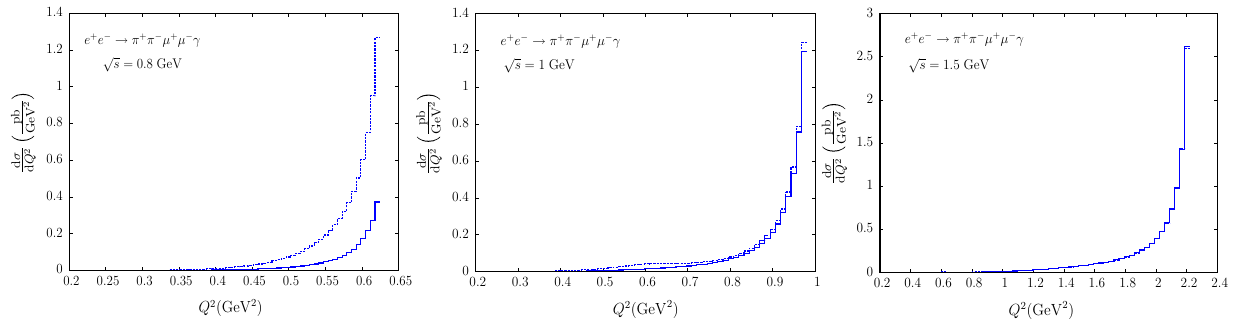
Fig. 16 The differential cross sections of (10) as functions of invariant mass of the π + π − μ + μ − -system computed in a model with the charged pion form factor ( solid lines ) and in the HLS model with fixed couplings ( dotted lines )